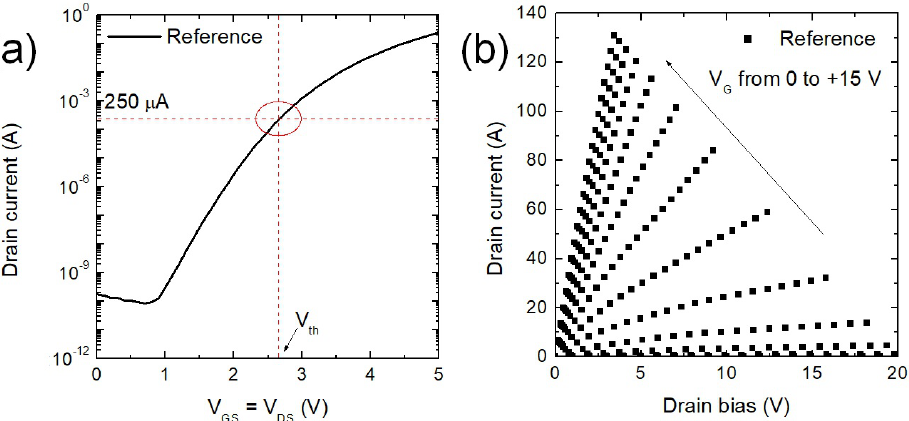
Figure 5. Experimental electrical measurements carried out on a reference MOSFET. The trans- characteristic I D -V GS is shown to demonstrate how the V th value is defined at fixed current value ( a ). ( b ) The output characteristics I D -V D reported for V G values up to +15 V are used to determine the R ON value at 10 A.